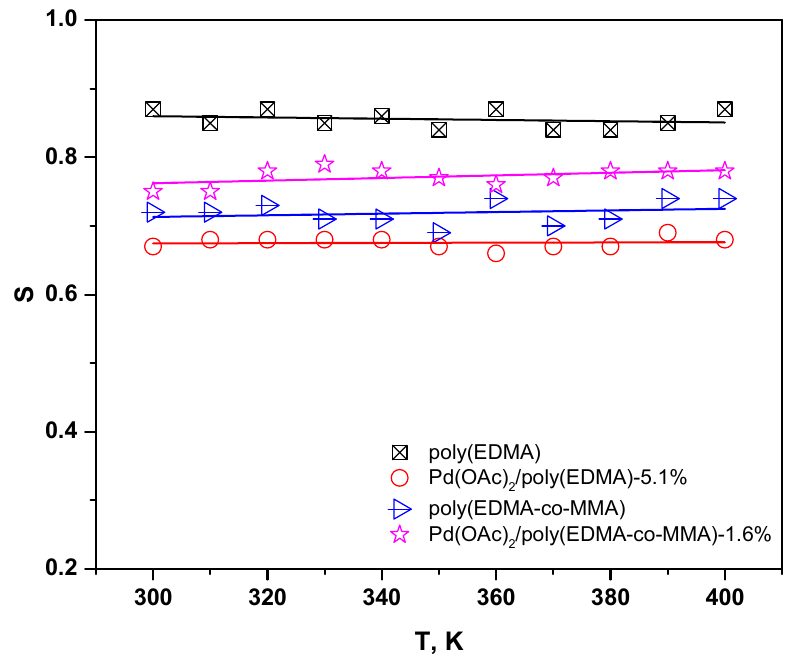
Figure 9. Dependence of the S value on the temperature for ( A ) poly(EDMA), ( B )